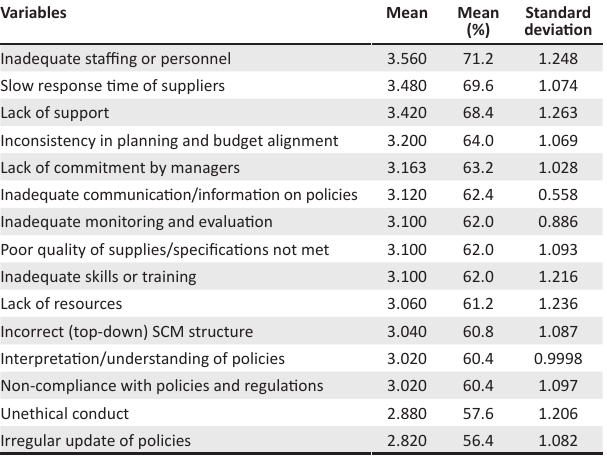
TABLE 6: Ranked challenges from follow-up survey. Variables Mean Mean